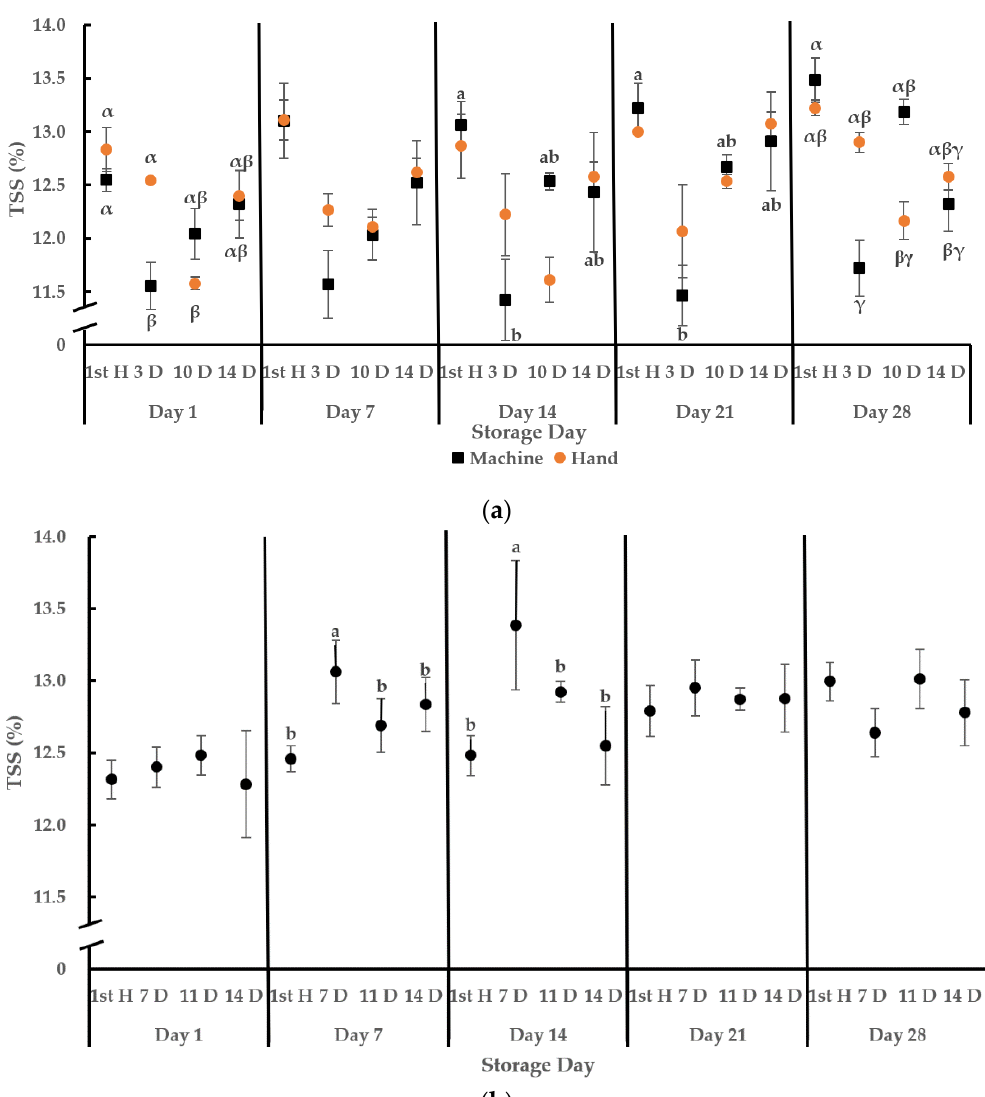
Figure 4. Total soluble solids (TSS) of ‘Liberty’ northern highbush blueberry in 2019 ( a ) and 2020 ( b ) at 1, 7, 14, 21, and 28 days after packing. Fruits were harvested at 3-, 10-, and 14-day harvest intervals in 2019 and at 7-, 11-, and 14-day harvest intervals in 2020. The first harvest was the baseline from which interval treatments were established. Fruits were harvested by hand or using a modified over-the-row (OTR) harvester with patent-pending elastomeric polymers installed on catching surfaces in northwest Washington, USA. Values are mean ± SE ( N = 6). Different lowercase letters indicate significant differences ( p < 0.05) due to interval effects on each evaluation day. Different Greek letters indicate significant differences ( p < 0.05) among both hand- and machine- harvested fruit on each evaluation day due to interaction effects of harvest method and interval. Hand and machine harvesting data are combined in 2020 due to lack of harvest method or interaction effects ( b